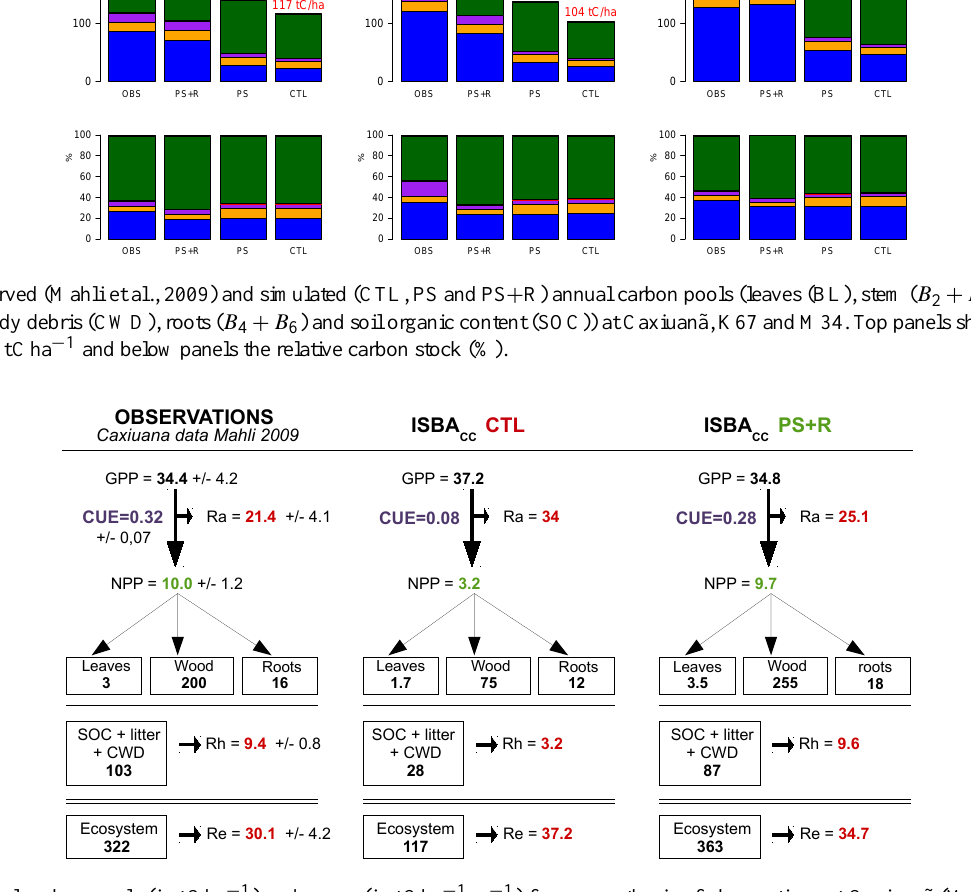
Figure 9. Annual carbon pools (in tCha − 1 ) and fluxes (in tCha − 1 yr − 1 ) from a synthesis of observations at Caxiuanã (Malhi et al., 2009) compared to ISBA CC (CTL and PS + R simulations). Adapted from Randerson et al.